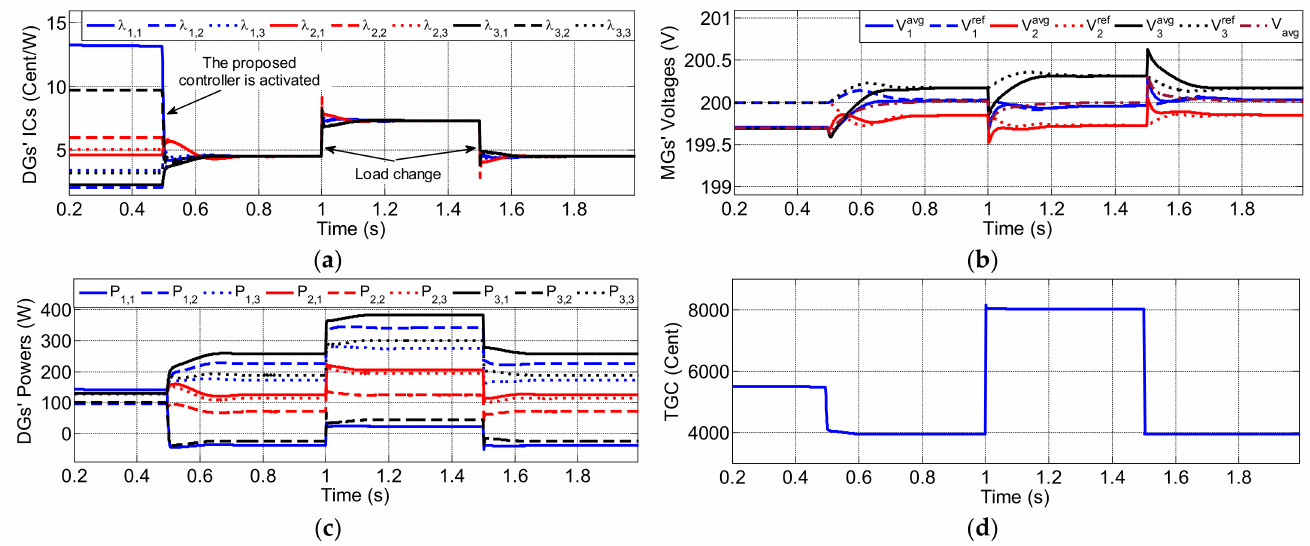
Figure 4. Control system’s performance: ( a ) DGs’ incremental costs, ( b ) MGs average voltages, ( c ) DGs’ output powers, and ( d ) Global